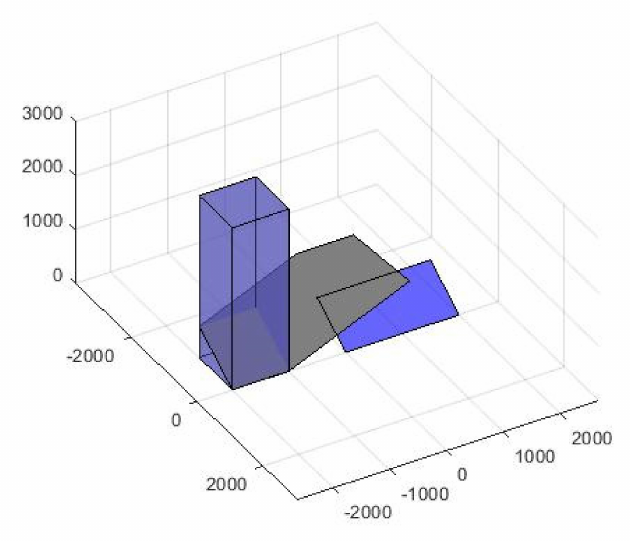
Figure 7. Visual output of one module and one obstacle casting a shadow on the plane defined by the